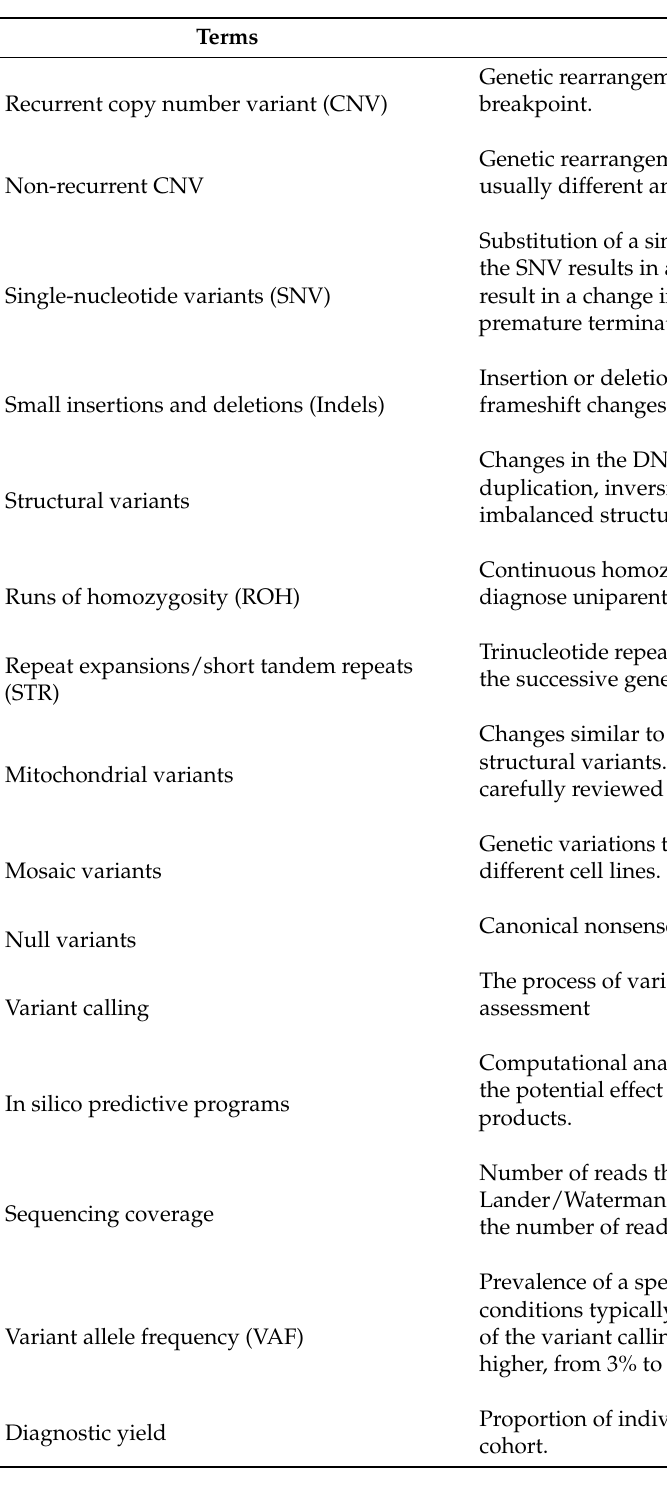
Table 2. Definitions of Key Terminology in Genetic Molecular